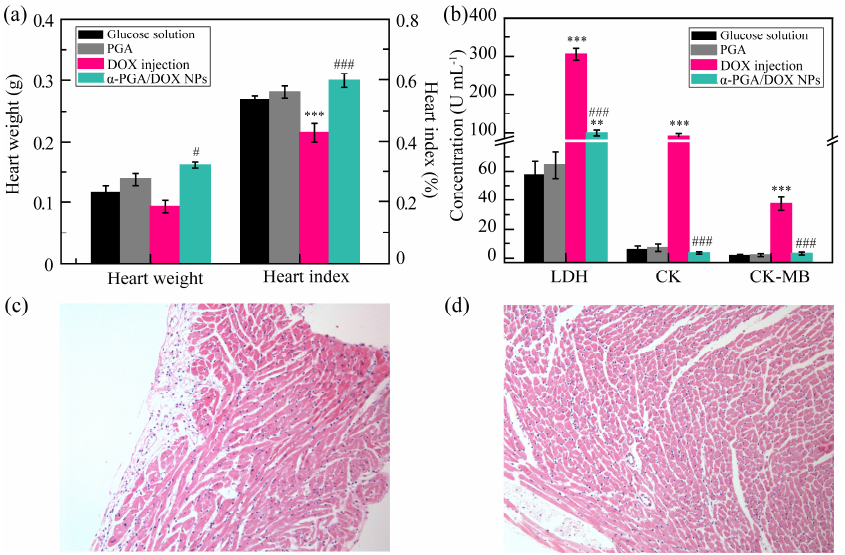
Figure 8. Cardiotoxicity measurement: heart weight and heart index ( a ), enzymatic marker concen- tration ( b ), heart tissue images of the DOX group ( c ) and α-PGA/DOX NP group ( d ) ( n = 10). ** p < 0.01, *** p < 0.001, vs. glucose solution; # p < 0.05, ### p < 0.001, vs. DOX injection.